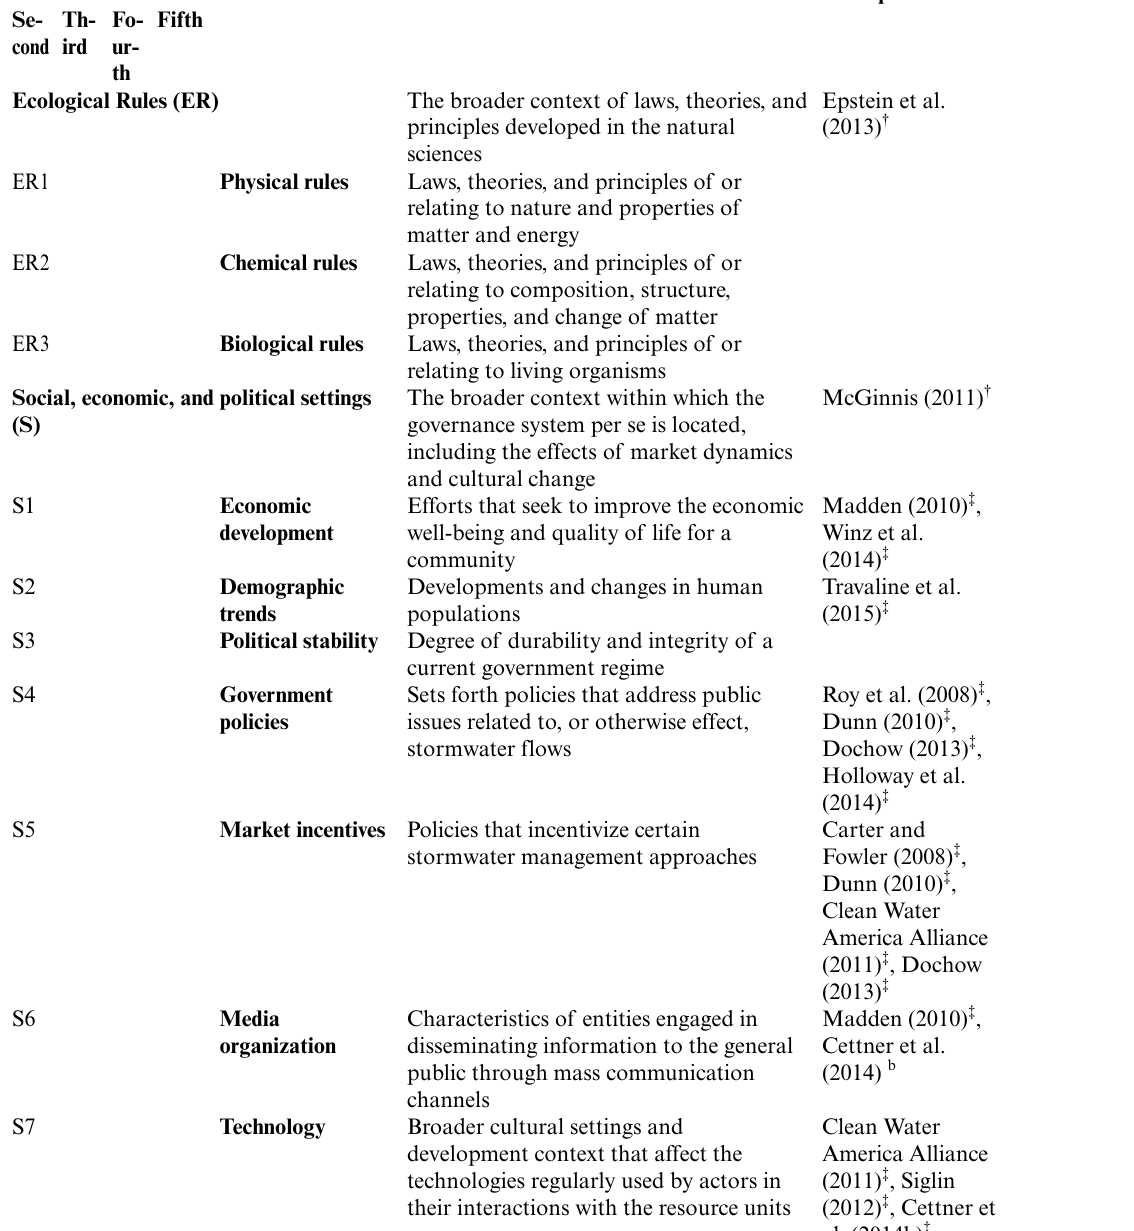
Table 1: Modified framework for green infrastructure adoption in urban stormwater social-ecological systems. References provided as working definitions and illustrative examples from the literature. Tier